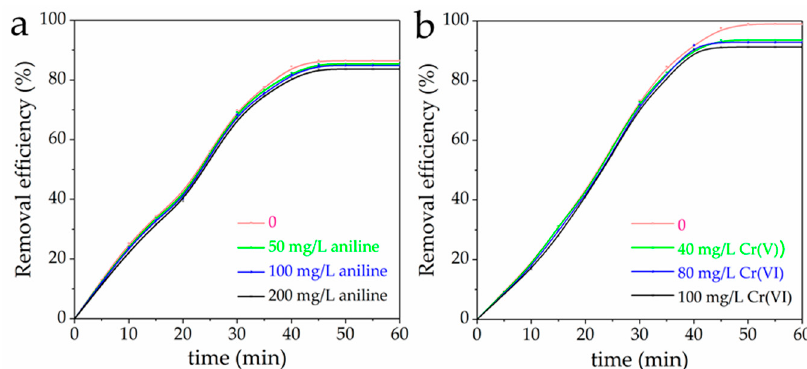
( c 0 (Cr(VI)) = 40.0 mg·L − 1 , c (MFH) = 0.10 g·L − 1 , pH = 3.0, T = 25 °C). ( b ) Removing aniline with various initial concentrations of Cr(VI) by MFH. ( c 0 (aniline) = 100.0 mg·L − 1 , c (MFH) = 0.10 g·L − 1 , pH = 3.0, T = 25